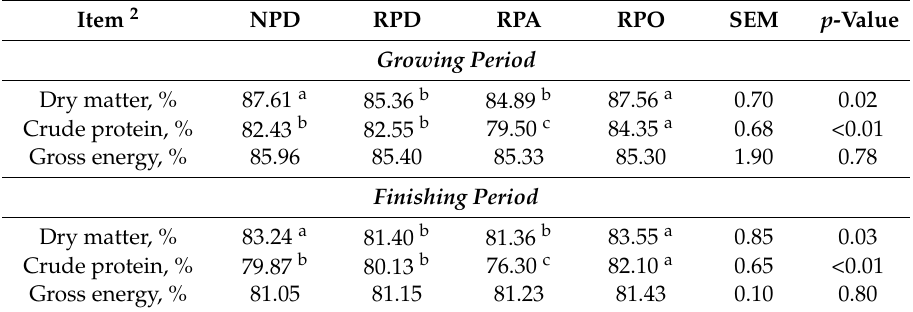
Table 3. Effects of inclusion of oregano essential oil in a low-protein diet on apparent total tract nutrient digestibility of growing-finishing pigs 1